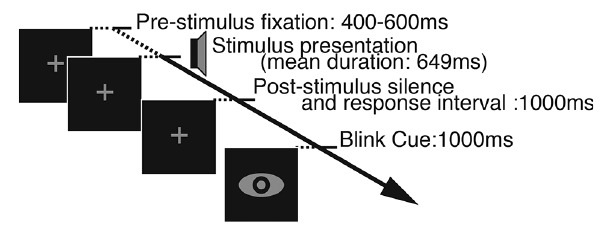
FIGURE 2 | Illustration of a single trial . In the beginning of each trial a fixation cross appeared on the screen for a variable duration of 400–600 ms and remained on the screen as the stimulus was presented. One second of silence was inserted after the stimulus offset, during which participants could make their response, and it was followed by the blink cue whose duration was also fixed at 1